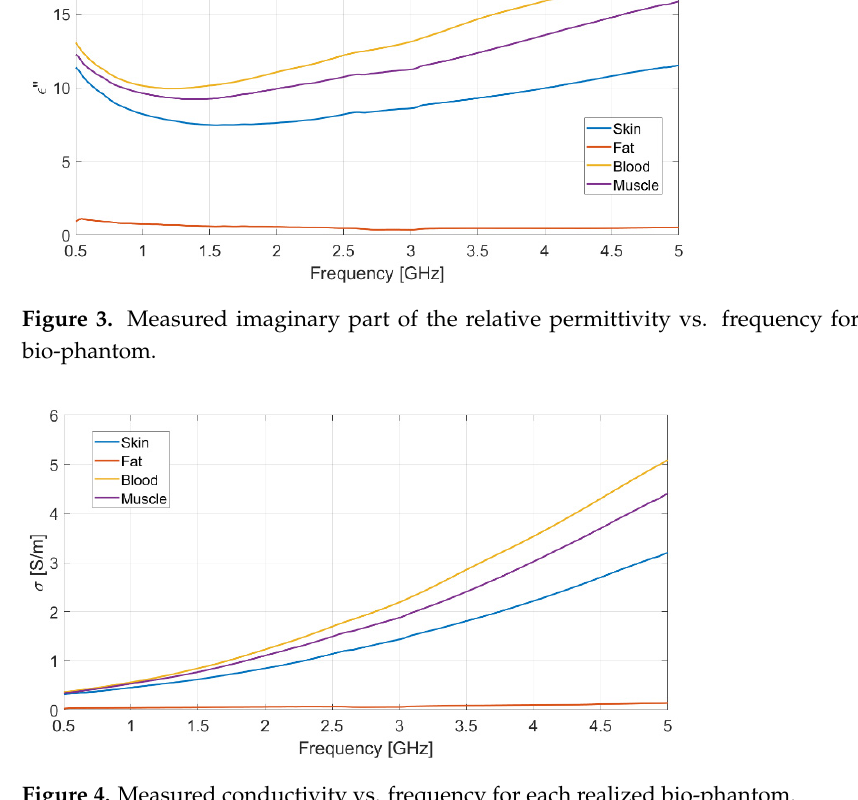
Figure 4. Measured conductivity vs. frequency for each realized bio-phantom.